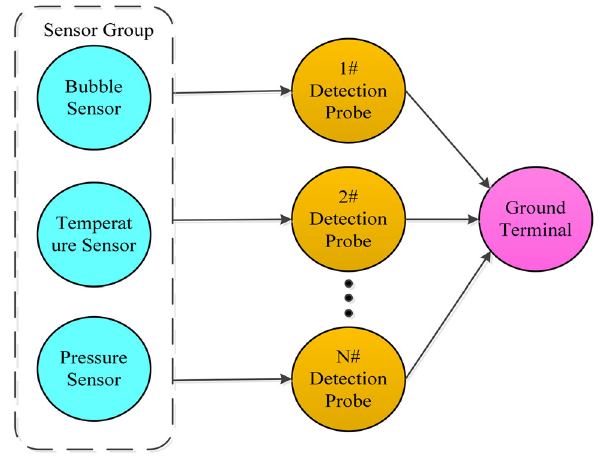
Fig. 2 Measuring device schematic